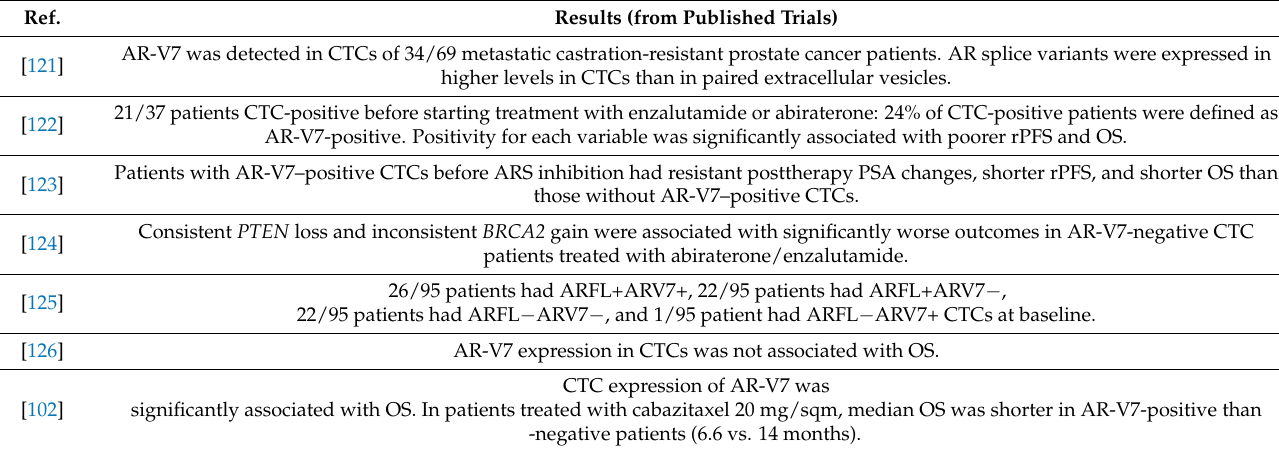
Table 3. AR-V7 in metastatic castration-resistant prostate